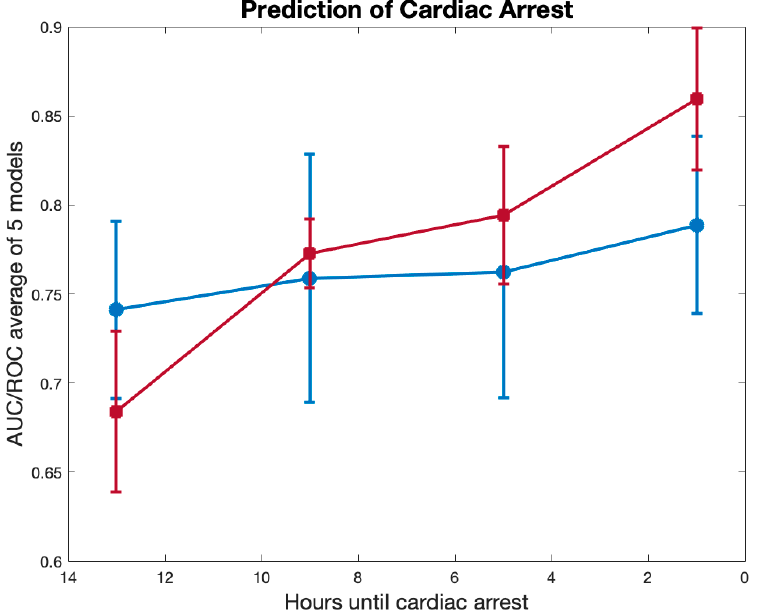
Figure 3. Comparison of the predictive machine learning algorithm (red) to the Gaussian Naïve Bayes model (blue). The x axis represents the number of hours until the cardiac arrest. The y axis represents the AUROC of the corresponding model at the corresponding hour.